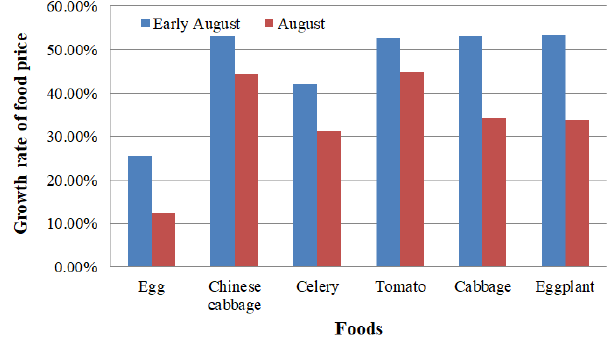
Figure 13. The YoY growth rate of some typical foods.